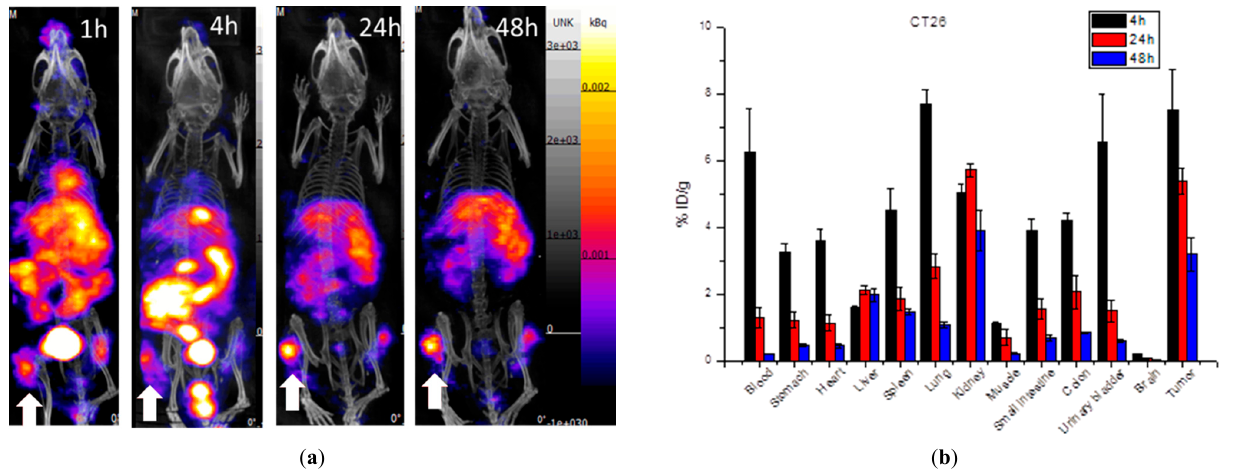
Figure 5. ( a ) SPECT/CT images and ( b ) biodistribution of 111 In-DOTA-NIR790 in mice bearing subcutaneous CT-26 colon cancer ( n = 3 at each time point). Arrow indicates tumor.